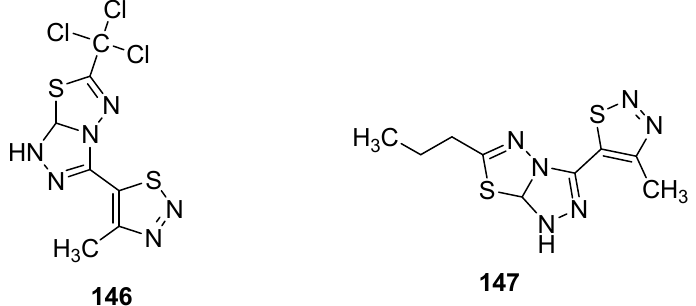
Figure 30. 1,2,3-thiadiazoles with broad antifungal activity.